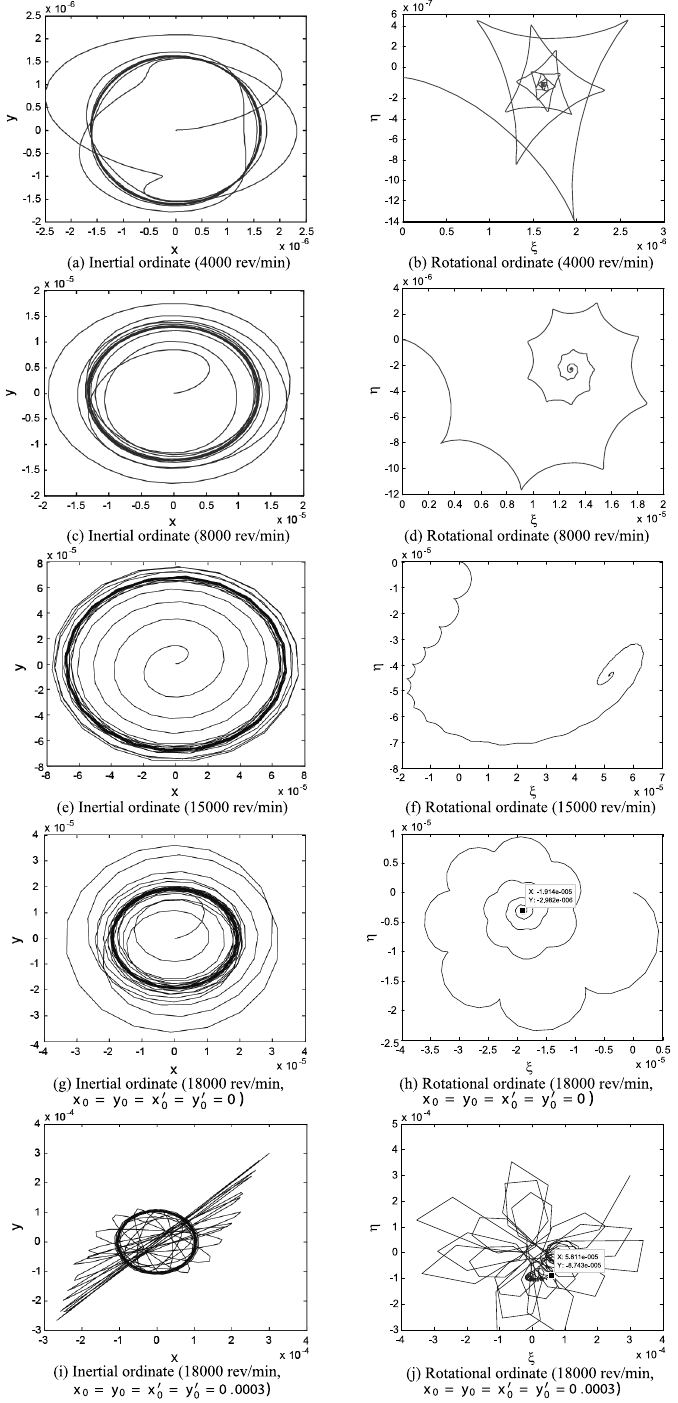
Fig. 8. Locus of axis centre of the rigid support